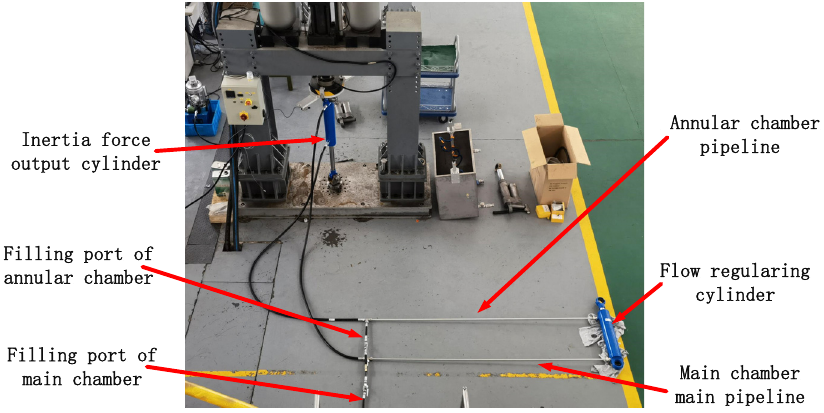
Figure 12. Test layout of dual-cylinder fluid inerter.